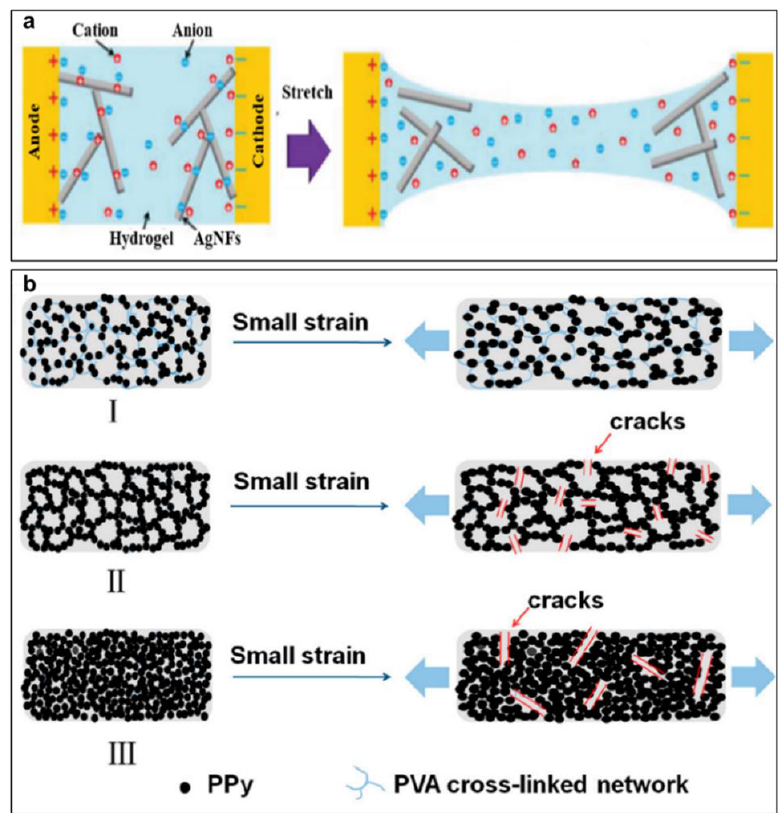
Figure 7. ( a ) Schematical illustration of a strain sensor based on CPHs (reprinted with permission from ref. [16]); and ( b ) the piezoresistivity mechanism of a PVA – PPy strain sensor when applying small strain (reprinted with permission from ref. [91]).